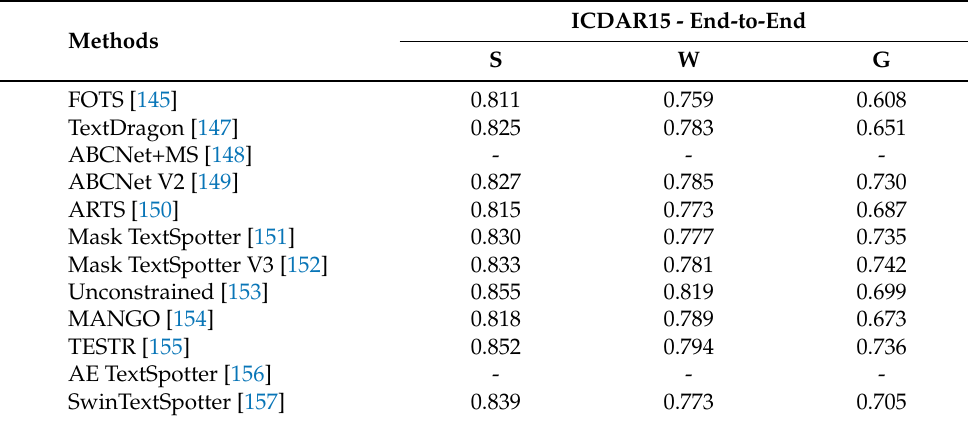
Table 9. Comparison of end-to-end text recognition in ICDAR2015. The acronyms “S”, “W” and “G” represent the “Strong”, “Weak” and “Generic” lexicon, respectively.